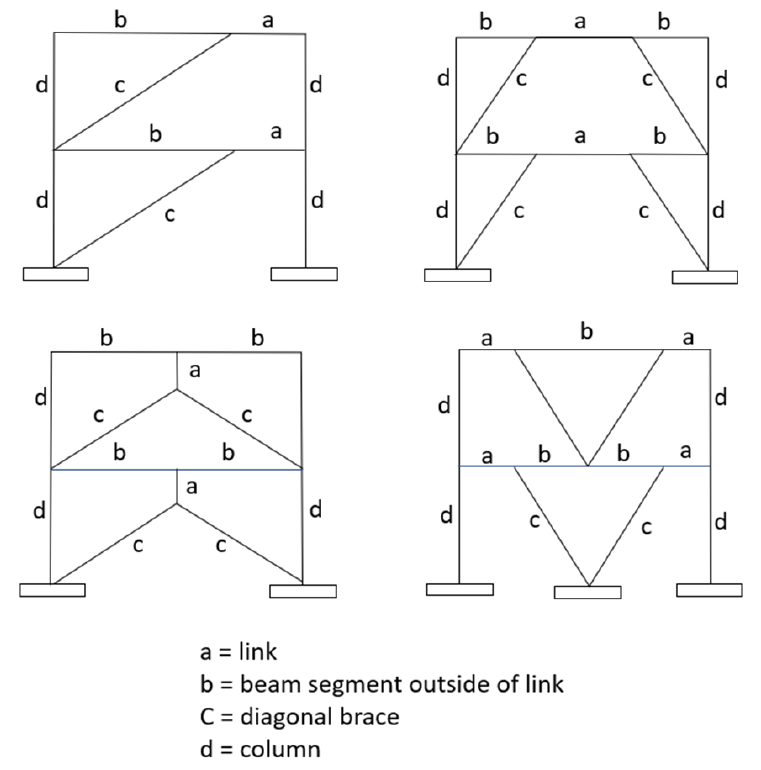
Figure 3. Types of Eccentrically Braced Frame. (Sketch by K. Al-Kodmany; adapted from [11]).